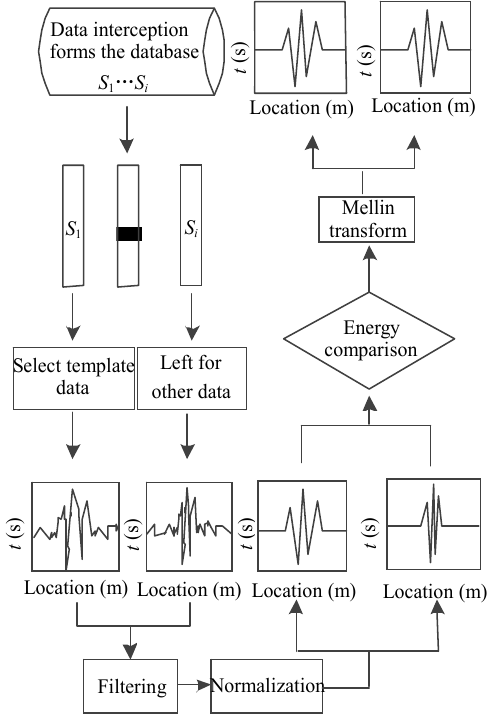
Fig. 1 Flow chart of signal scale correction based on the MT.